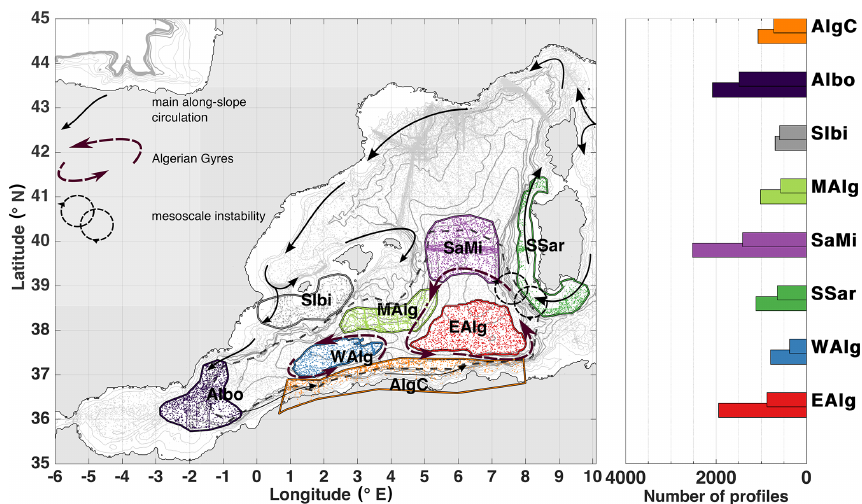
Figure 1. Maps of the western Mediterranean Sea, showing the general circulation pattern of LIW. The colored polygons define the areas used to select data for our comparative study. The dark gray dashed contour line define the area used to compute the basin-averaged trends. The background contour lines represent the bathymetry of the region. The gray dots (and colored ones inside the polygons) represent a scatter of LIW temperature data between 1960 and 2017. The bar plot on the right panel shows the total number of profiles containing a LIW core characteristic in each polygon (bottom bar for θ , top one for salinity). The labels of the corresponding polygons are written in the y axis.